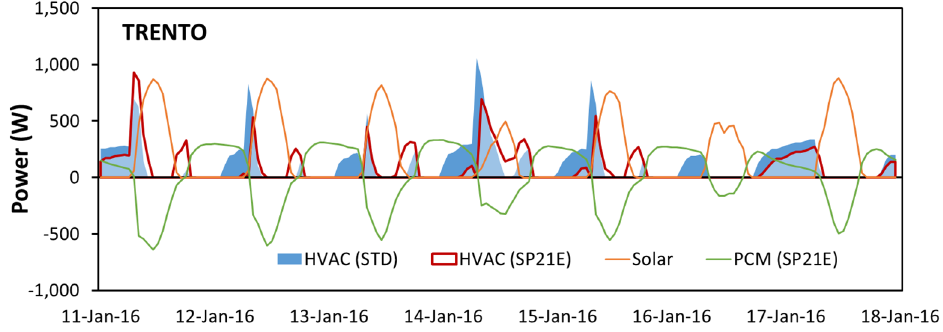
Figure 13. PCM acting in heating mode. Example of heat balance for a week in January in the city of Trento.